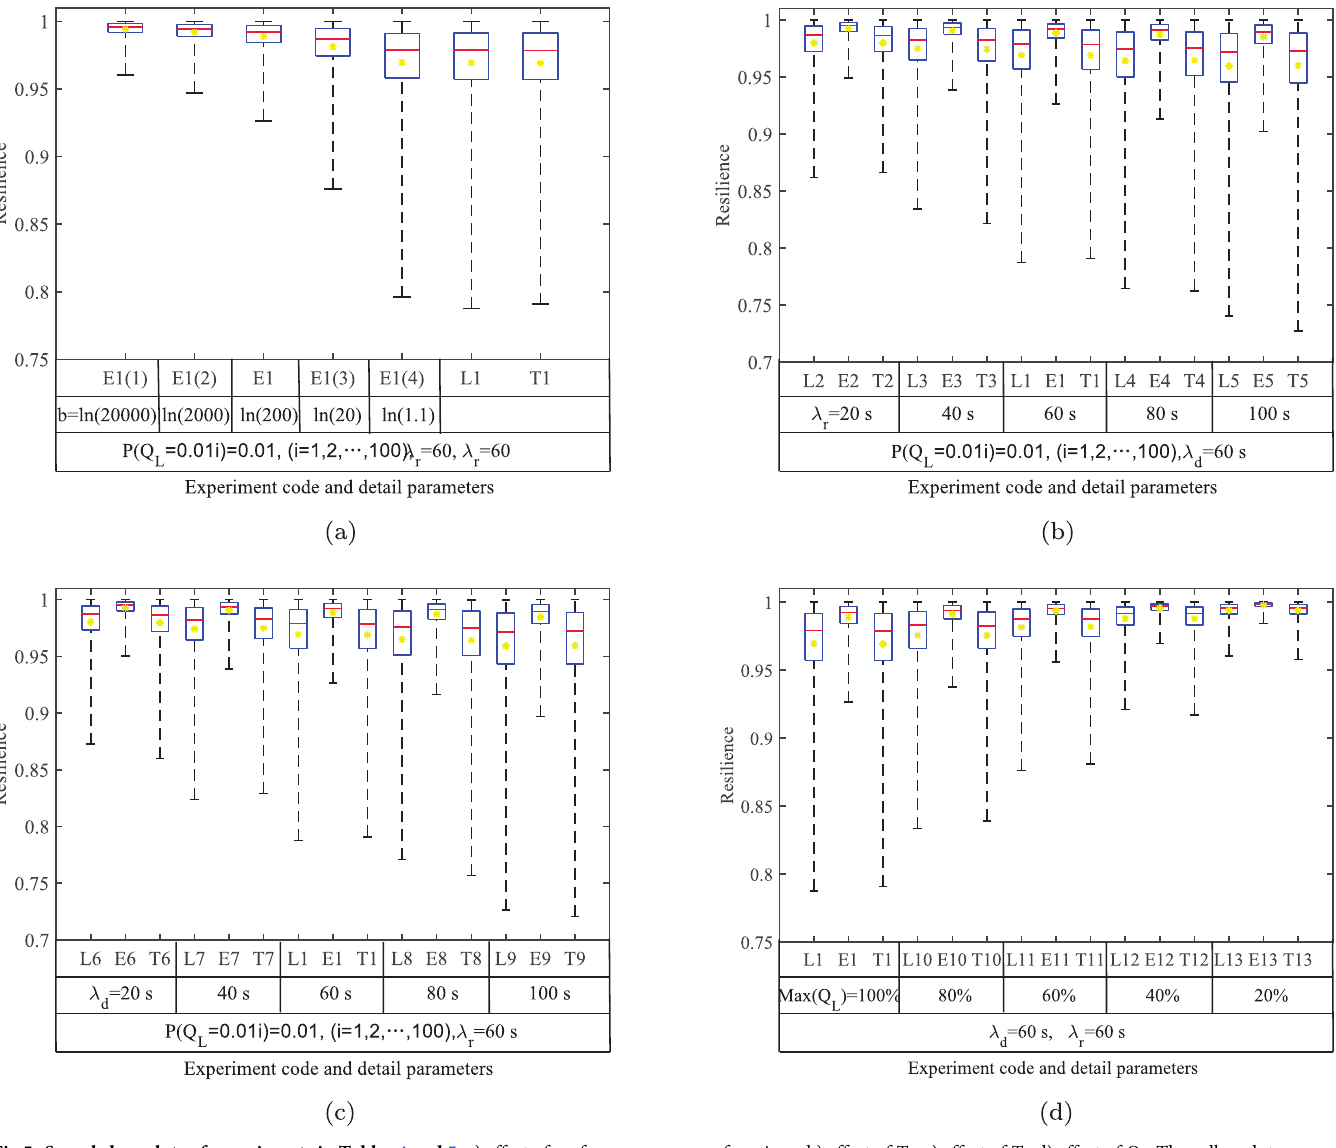
, the red lines represent the median resilience ℝ D , respectively, and the top and bottom lines represent the maximum resilience ℝ D ; 0 : 25